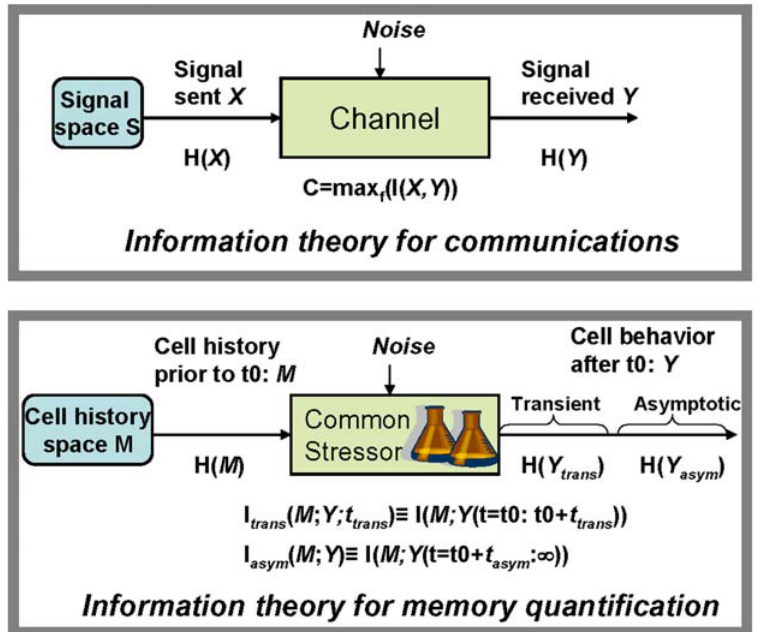
Figure 3. Information-based conceptual schema for measuring memory in microbes. In communication theory (top), the informational entropy of the signal space H( X ) captures the number of different messages X that can be communicated and their probabilistic dispersal; the mutual information I( X,Y ) between transmitted and received signals quantifies the amount of information actually communicated. A memory experiment, in contrast, involves subjecting cells to distinct treatments M prior to time t0, followed by an identical treatment S after time t0, with cell behavior from t0 on monitored through temporal sampling of one or more observable variables Y . As applied to bacterial memory (bottom), the informational entropy of the cell history space H( M ) captures the number of different cell histories prior to time t0 tested by the experimental compendium and their probabilistic dispersal; the mutual information I trans ( M;Y;t trans ) between the transient response of the observable variable Y after time t0 and the cell history prior to time t0 captures the short-term memory of cell history exhibited by Y over the cell history space in response to treatment S . Likewise, the mutual information I asym ( M,Y ) between the long-term response of Y and cell history prior to t0 captures the long-term memory of cell history exhibited by Y